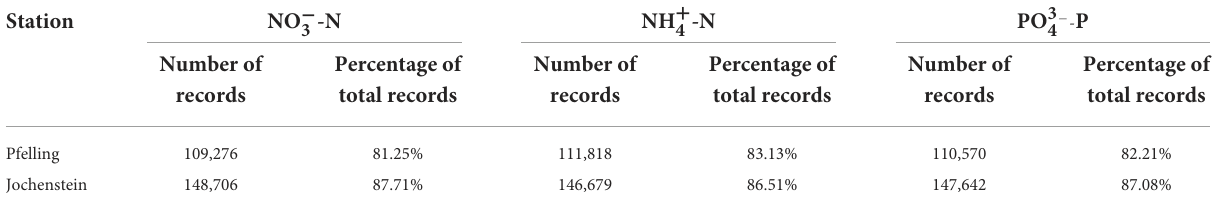
TABLE 2 Number of records and percentage of total records for different targets after cleaning.